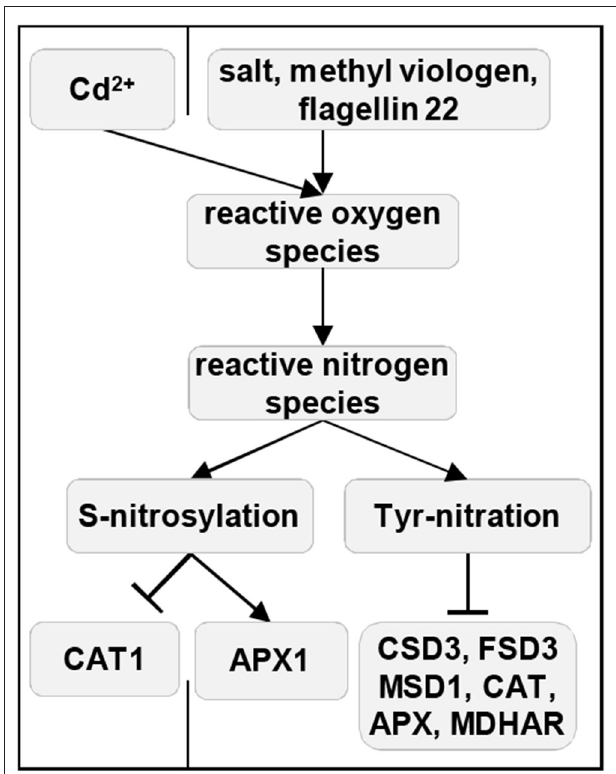
FIGURE 4 | Reactive nitrogen species-mediated direct regulation of antioxidant enzymes during plant stress responses. Solid arrows indicate induction, and ⊥ indicates negative regulation. APX, ascorbate peroxidase; CAT, catalase; FSD, Fe superoxide dismutase; MDHAR, monodehydroacorbate reductase; MSD, Mn superoxide